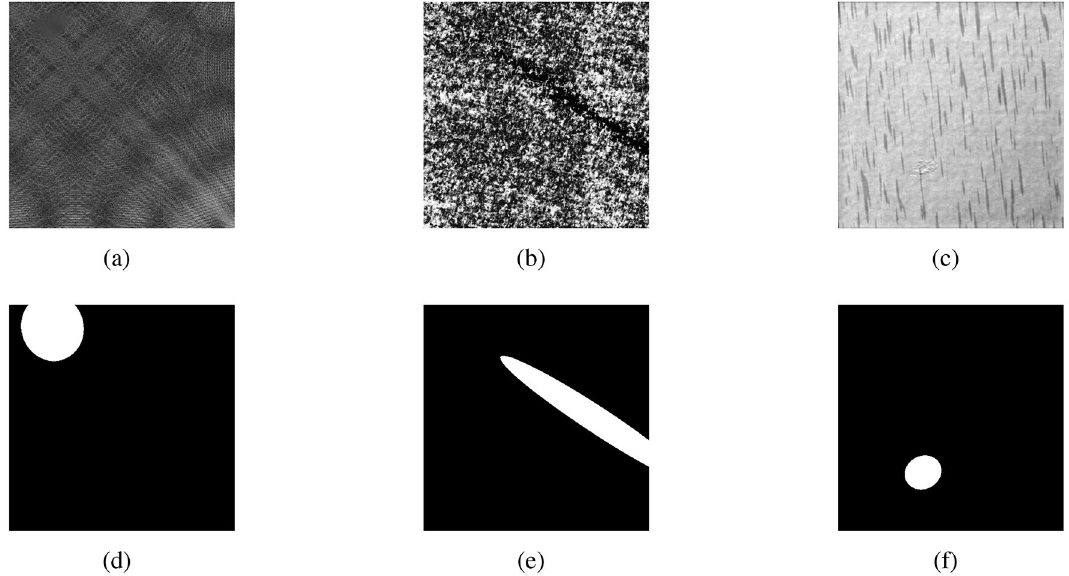
Figure 4. The three selected categories of defective samples and their labels. ( a–c ) Are Class 1, Class 6, and Class 7 respectively, and ( d – f ) are their corresponding